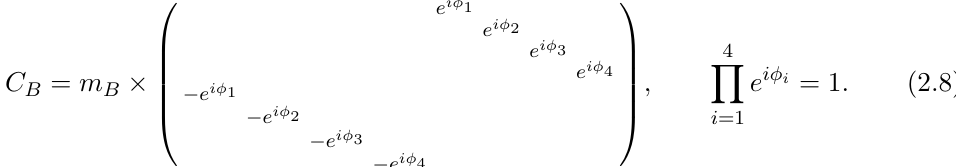
Figure 1 . θ is parametrizing SO(2) SO(2)